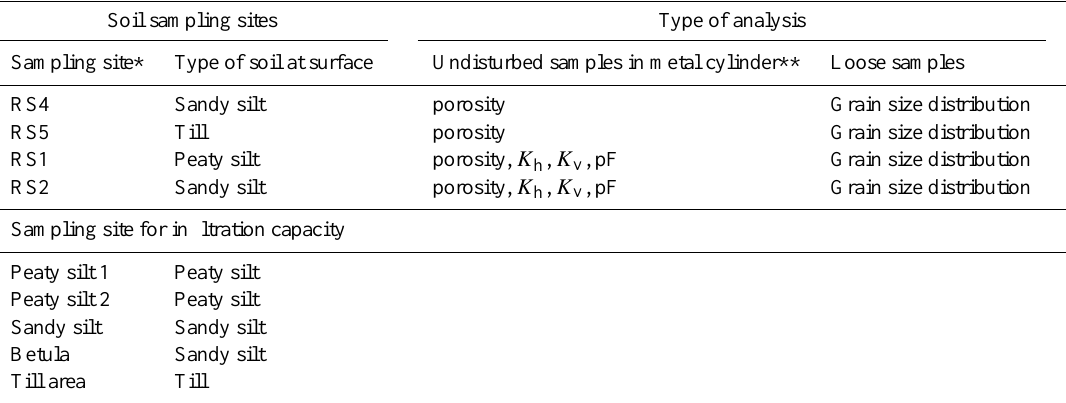
Table 3. Soil sampling sites and types of analysis performed.